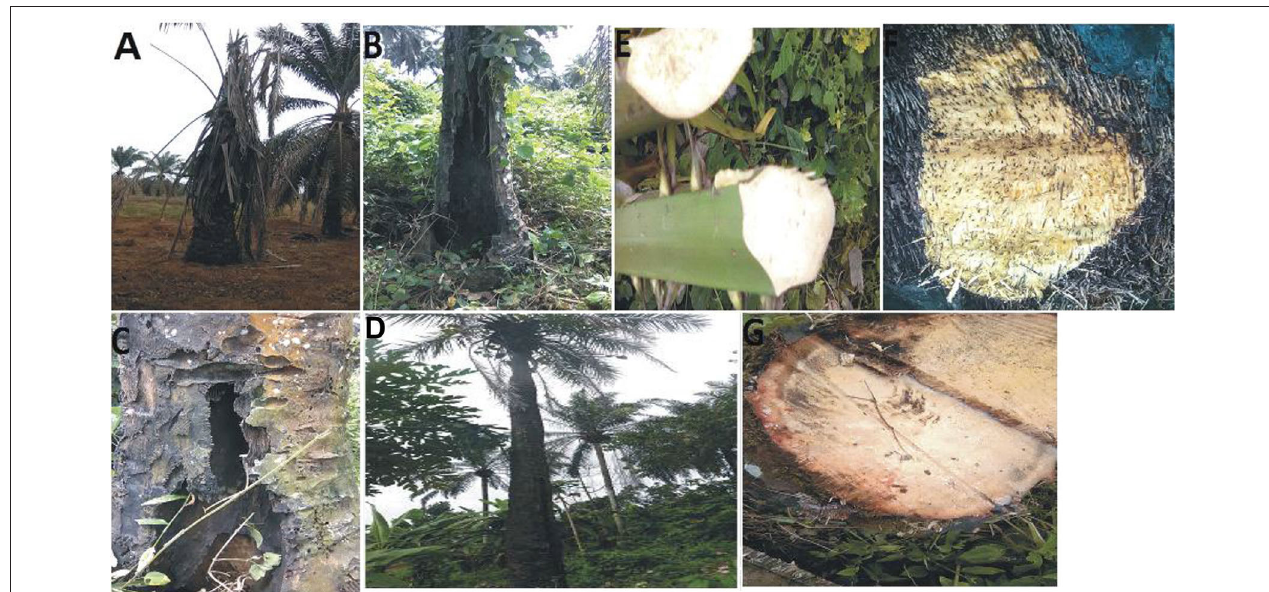
FIGURE 1 | (A) Chronic symptoms of Fusarium wilt disease with wilting leaves. (B) Chronic symptoms of Fusarium wilt disease revealing extreme cracking of the trunk. (C) Chronic symptoms of Fusarium wilt disease with perforations in the vascular bundles. (D) Chronic symptoms of Fusarium wilt disease with a thin terminating trunk. (E) Infected petiole of an acute infected oil palm. (F) The cut transverse section of the vascular bundle of an acute Fusarium wilt infected oil palm. (G) The inner tissues of the vascular bundles of an acute Fusarium wilt infected oil palm.